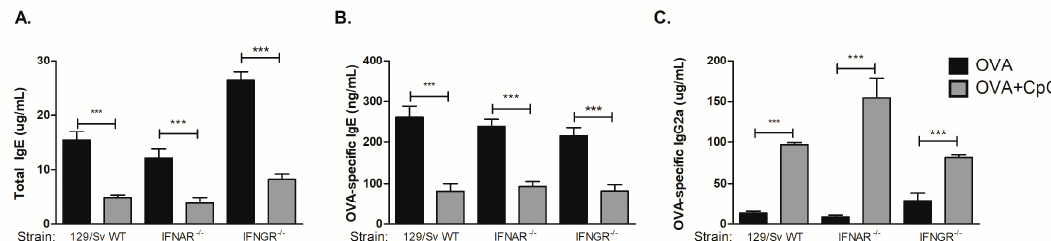
Figure 4. CpG-induced inhibition of IgE and augmented IgG2a production is independent of type I or type II interferon receptors. 129 WT strain or mice lacking type I interferon receptor (IFNAR − / − ) or type II interferon receptor (IFNGR − / − ) on 129 background were submitted to the same protocol of OVA sensitization with alum and i.n. OVA challenge. Experiments were performed on day 22. Serum levels of ( A ) total IgE, ( B ) OVA-specific IgE or ( C ) OVA-specific IgG2c were measured by ELISA. OVA groups ( n = 5) and OVA+CpG groups ( n = 5). Values represent the mean ± SD and are representative of two independent experiments. One-way ANOVA: *** p < 0.001.